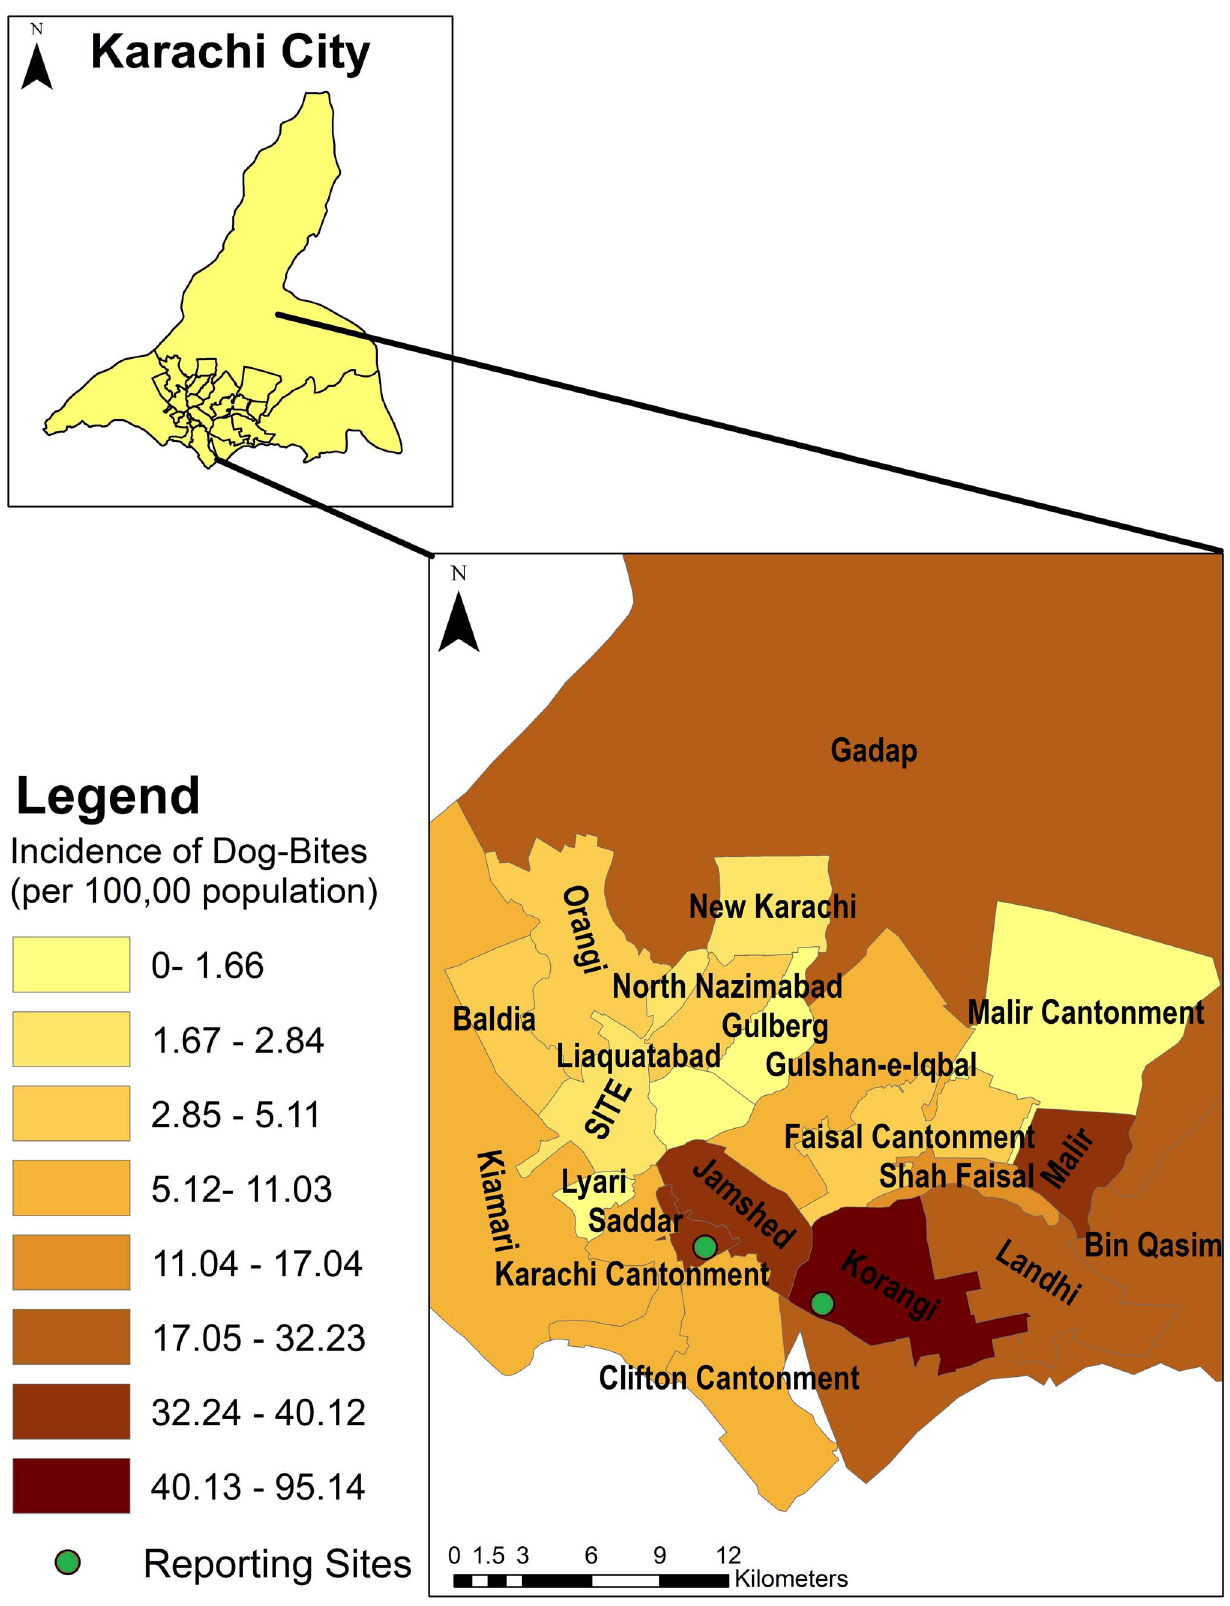
Figure 3. Incidence of dog-bite cases per 100,000 by administrative towns in Karachi, Pakistan between Feb 2009–Feb 2011.